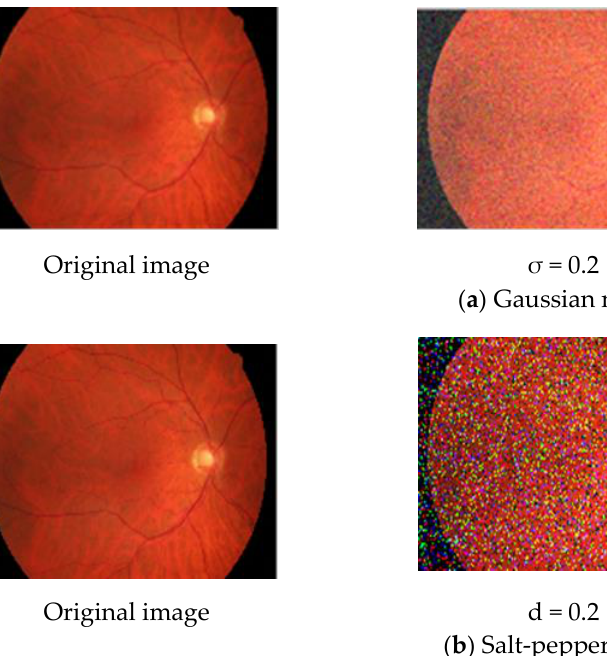
Figure 8. Sample fundus images with noise added.